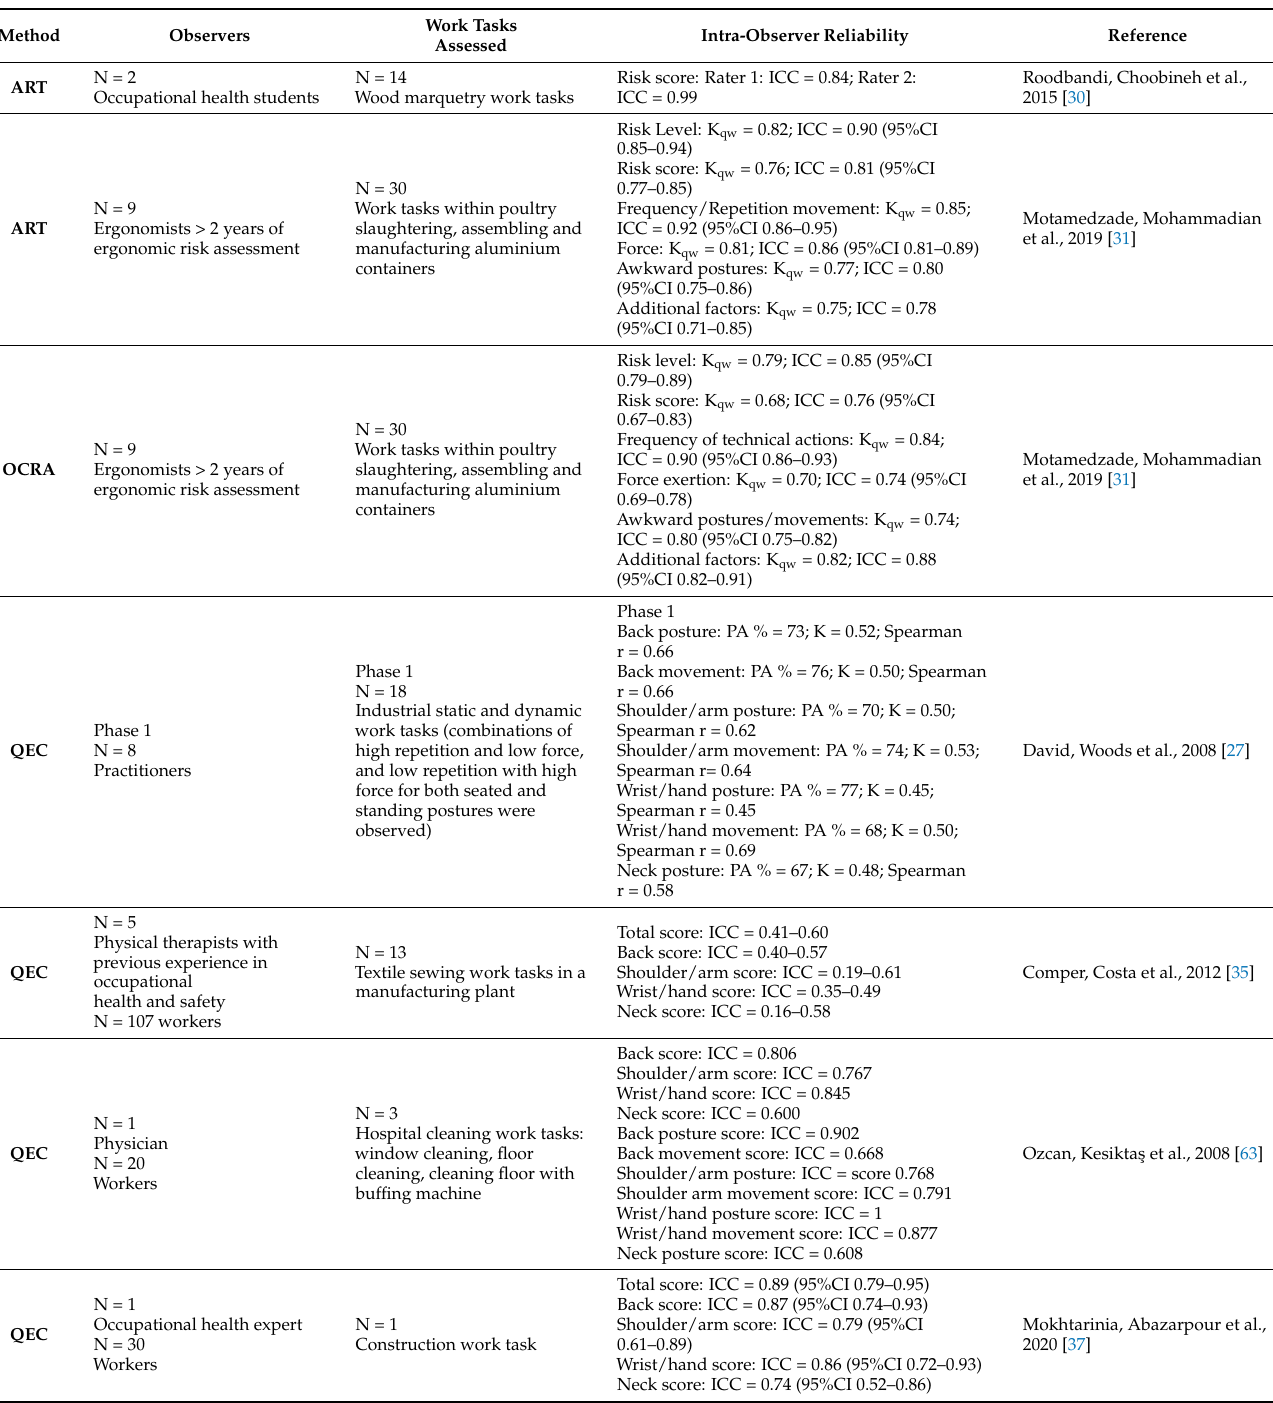
Table A2. Examples of studies that has assessed the intra-observer reliability of one of five risk assessment methods included in the study; Assessment of repetitive tasks of the upper limbs (ART); Hand Arm Risk Assessment Method (HARM); Occupational Repetitive Actions of the Upper Limbs checklist (OCRA); Quick exposure check (QEC); Strain Index (SI). (No reliability studies were found for SWEA). ICC = Intra Class Correlation, K = Cohens kappa, % = Proportional Agreement, K qw = Quadratically Weighted Kappa, K lw = Linearly Weighted